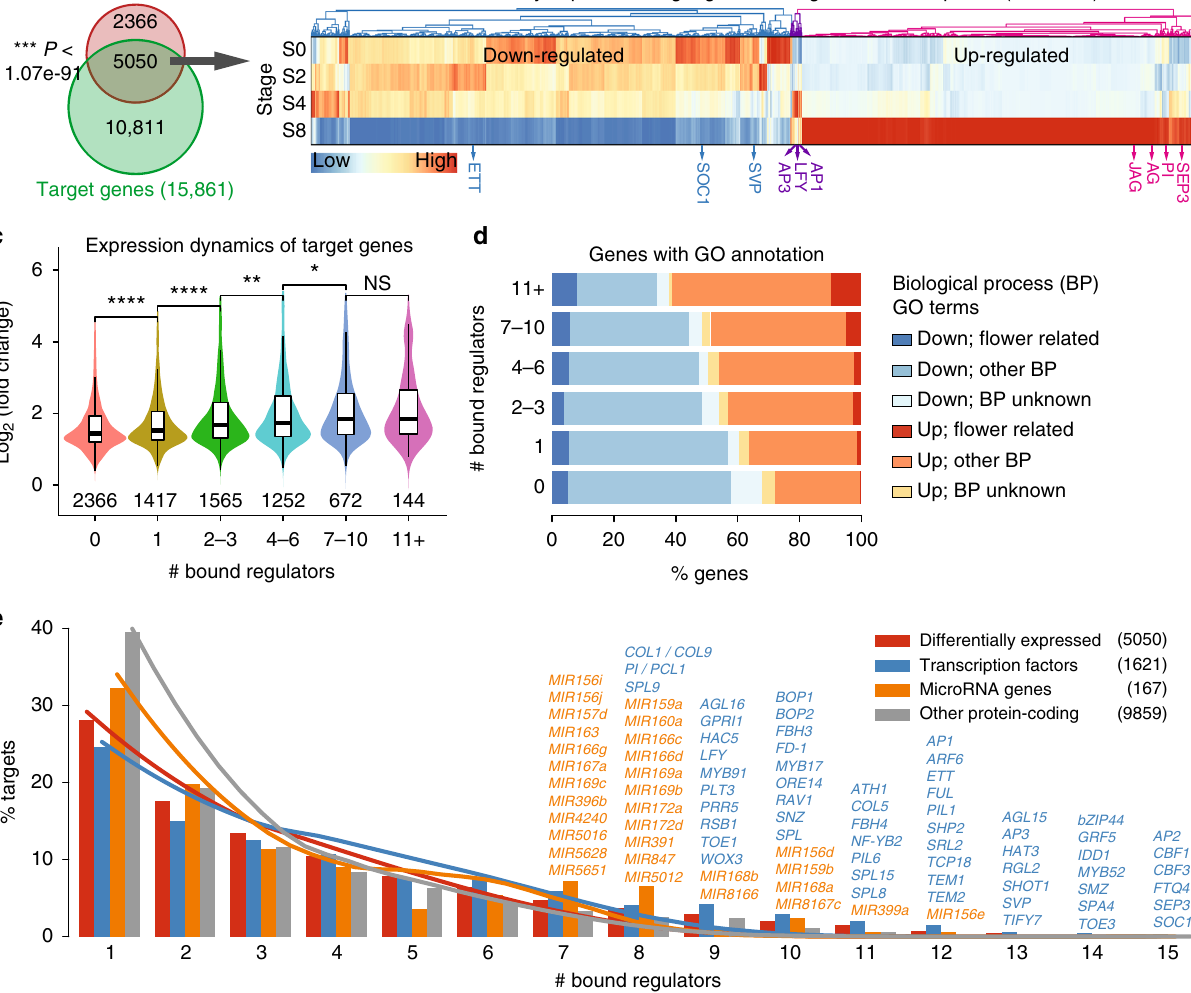
Fig. 2 Expression dynamics and functions of target genes regulated by fl oral regulators. a Venn diagram showing signi fi cant overlap ( P -value calculated by a hypergeometric test) of target genes by fl oral transcription factors (TFs; green) and differentially expressed (DE) genes across fl ower development (red). b Clustering analysis of DE target genes. Expression values are center normalized per gene based on its log 10 -transformed FPKM values in the four representative stages. The differentially expressed regulator genes are labeled. S0: stage 0. c Boxplot showing the distribution of expression changes (the maximum value of absolute fold change over stages) with increasing number of bound TFs. The number of genes in each category is labeled below the box. Boxes represent quartiles, center lines denote 50th percentile, and whiskers extend to most extreme values within 1.5× interquartile range